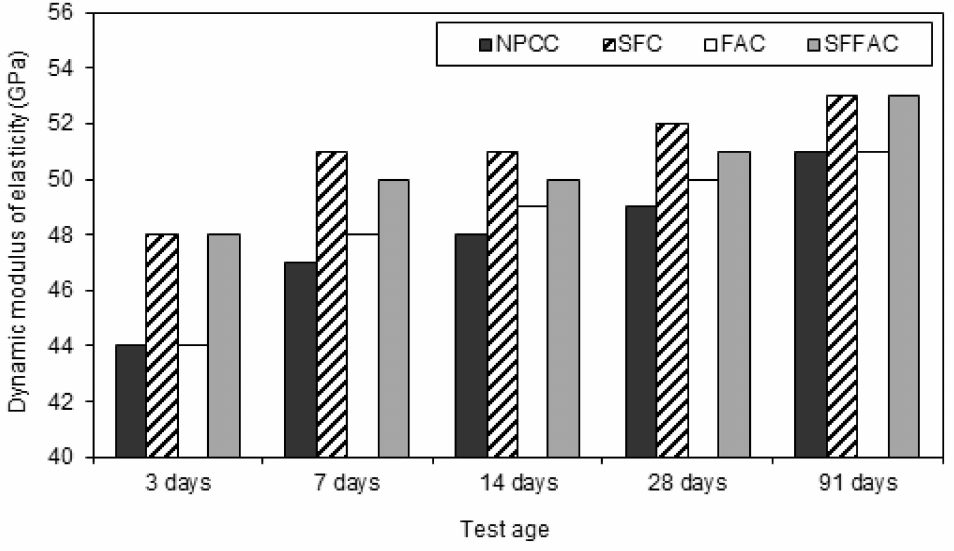
Figure 5. The dynamic modulus of elasticity of different types of concrete at various ages after water curing at a medium temperature of 20 ˝